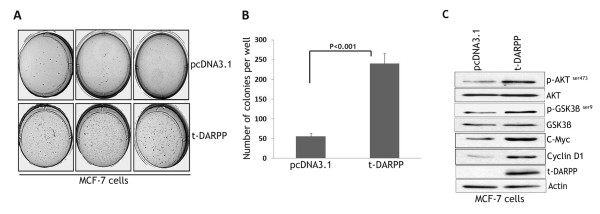
t-DARPP expression enhances anchorage-independent cell growth in soft agar. A, MCF-7 cells stably expressing t-DARPP or pcDNA3.1 empty vector were seeded in soft agar onto 6-well tissue culture plates (105 cells per well). The cells were grown for one month to allow for anchorage-independent colony formation. B, Quantification of colony formation indicated that MCF-7/t-DARPP cells produced markedly higher number of colonies than control cells (>4-fold increase, p < 0.001). C, Protein extracts from MCF-7/t-DARPP and MCF-7/pcDNA3.1 cells were analyzed by western blot for t-DARPP, p-AKT (S473), AKT, p-GSK3β (S9), GSK3β, C-Myc, Cyclin D1, and β-actin. t-DARPP expression directly correlated with increased phospho-AKTser473, phospho-GSK3βser9, C-Myc, and Cyclin D1 protein levels. Results are representative of at least three experiments and shown as the mean ± SD. Significance of difference was calculated using Student's t test analysis.